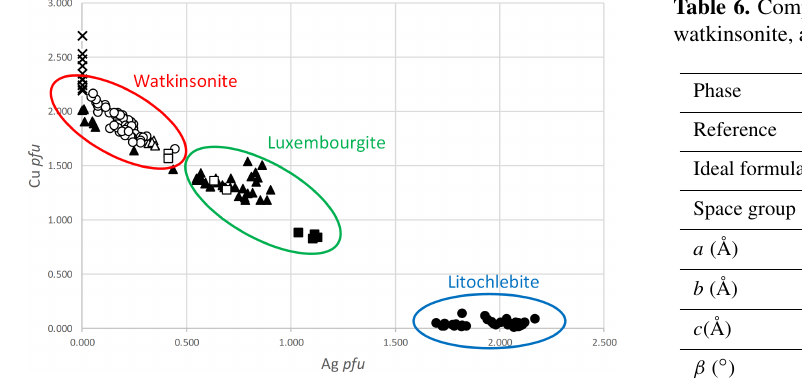
Figure 4. Ag / Cu plot, showing the compositions of luxembour- gite, watkinsonite, and litochlebite. Crosses represent watkinsonite from Otish Mountains (Johan et al., 1987). Black triangles repre- sent watkinsonite–luxembourgite from Zálesí (Sejkora, unpublished data). White triangles represent watkinsonite from Zálesí (Sejkora et al., 2012). Black circles represent a litochlebite holotype from Zálesí (Sejkora et al., 2011). White circles represent watkinsonite from Zálesí (Topa et al., 2010). Black squares represent luxembour- gite from Bivels (this paper). White squares represent watkinsonite– luxembourgite from Niederschlema (Förster et al., 2005).